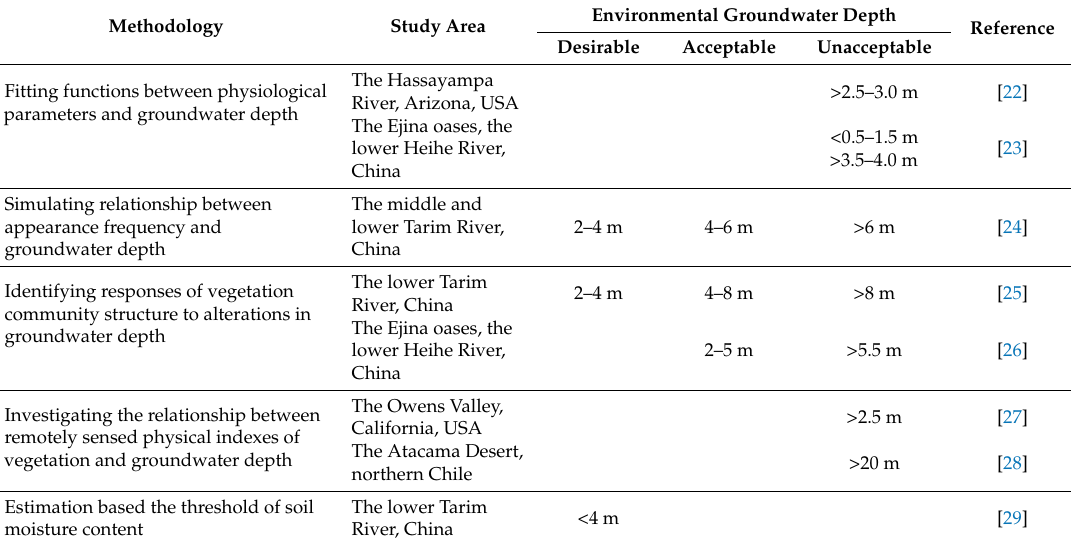
Table 1. Typical achievements of environmental groundwater